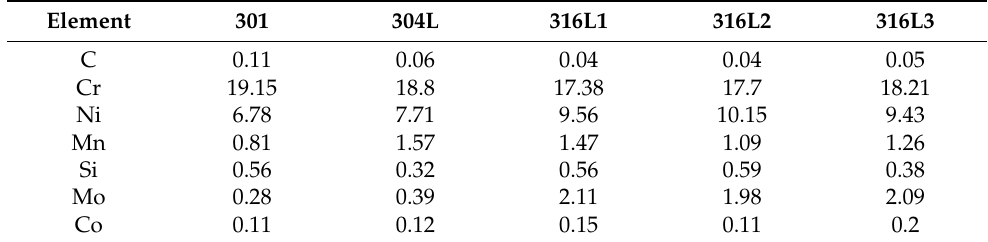
Table 1. Chemical composition (in weight %) determined by glow discharge optical emission spectrometry.